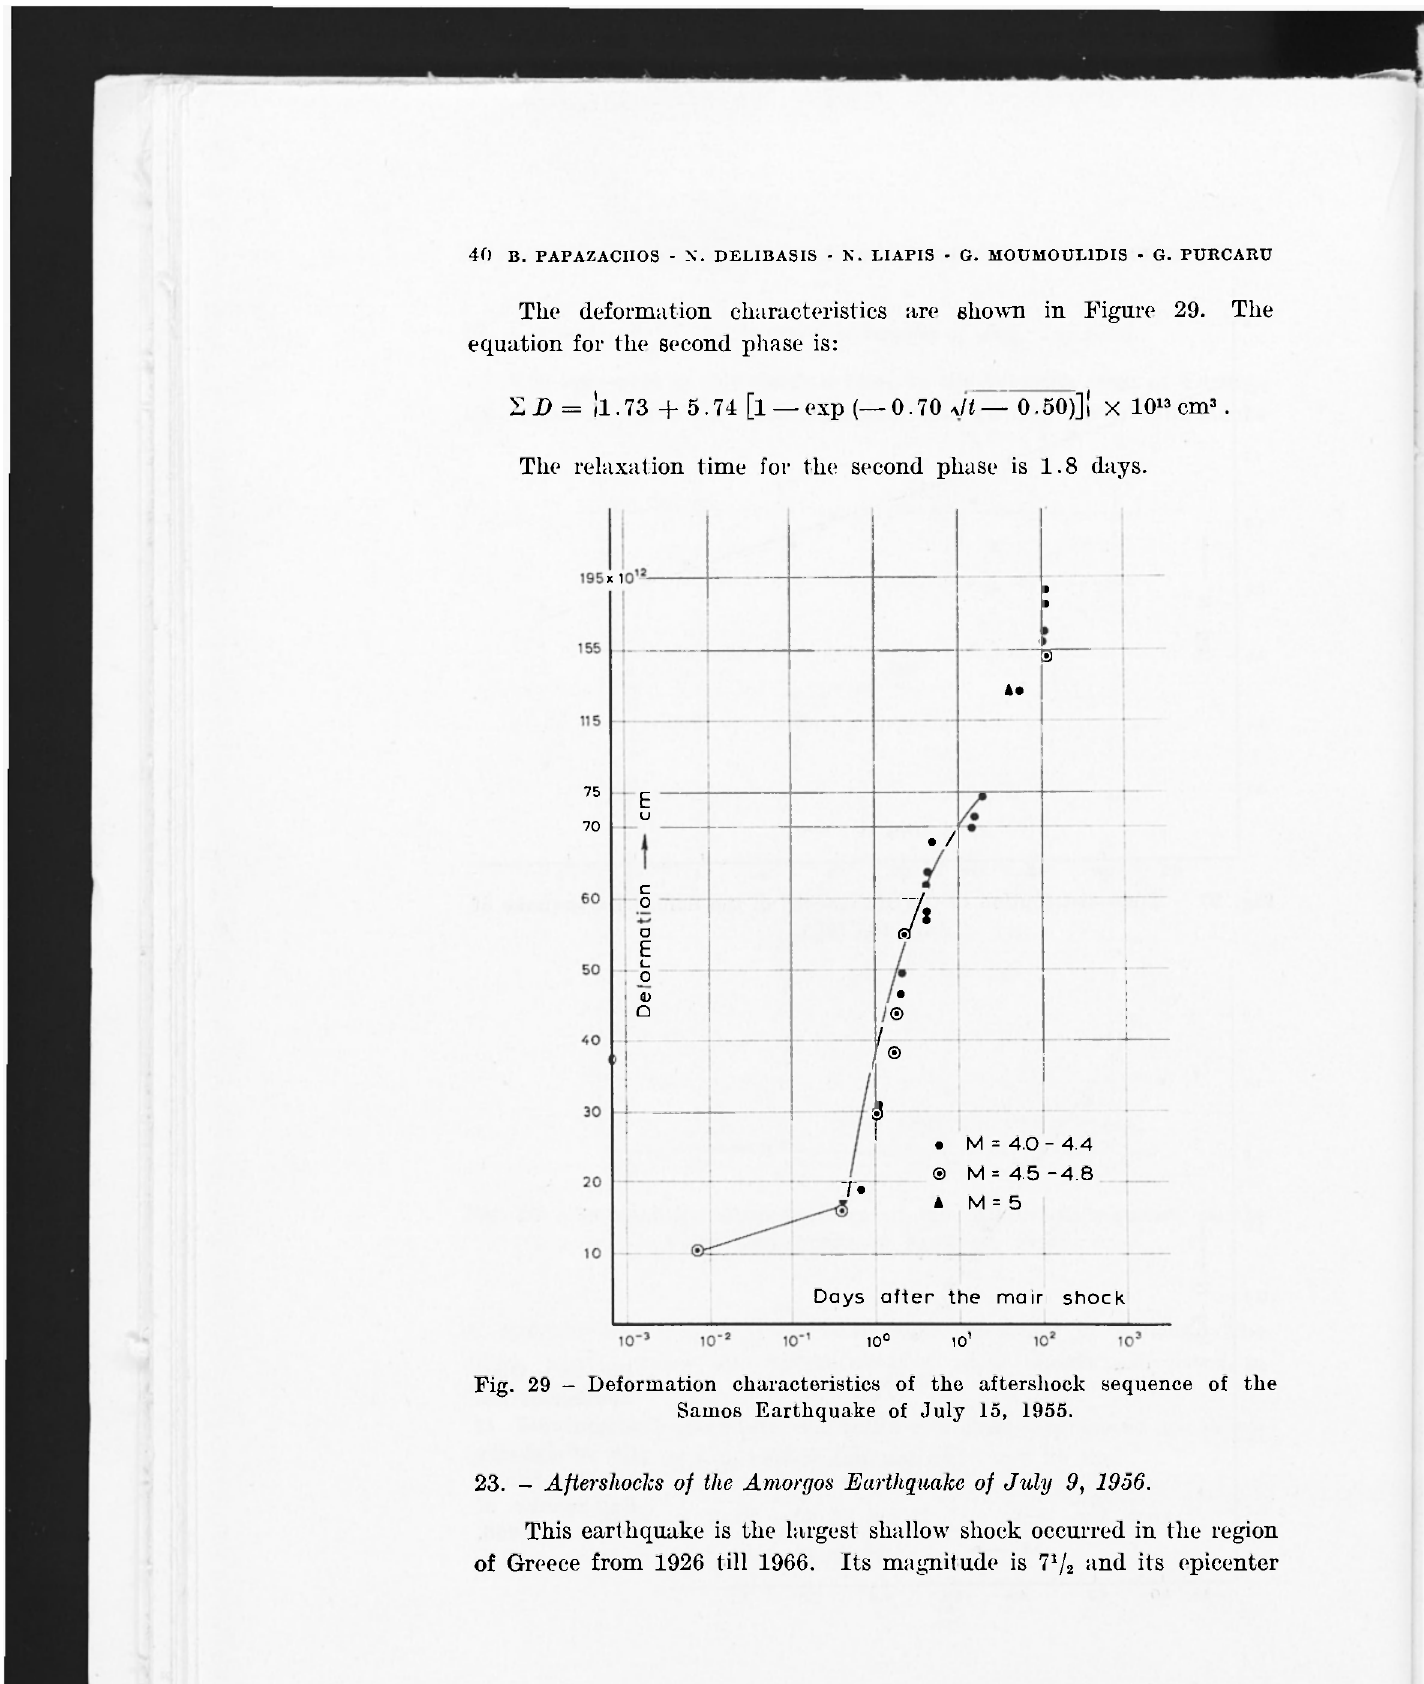
Fig. 29 — Deformation characteristics of the aftershock sequence of the Samos Earthquake of July 15,